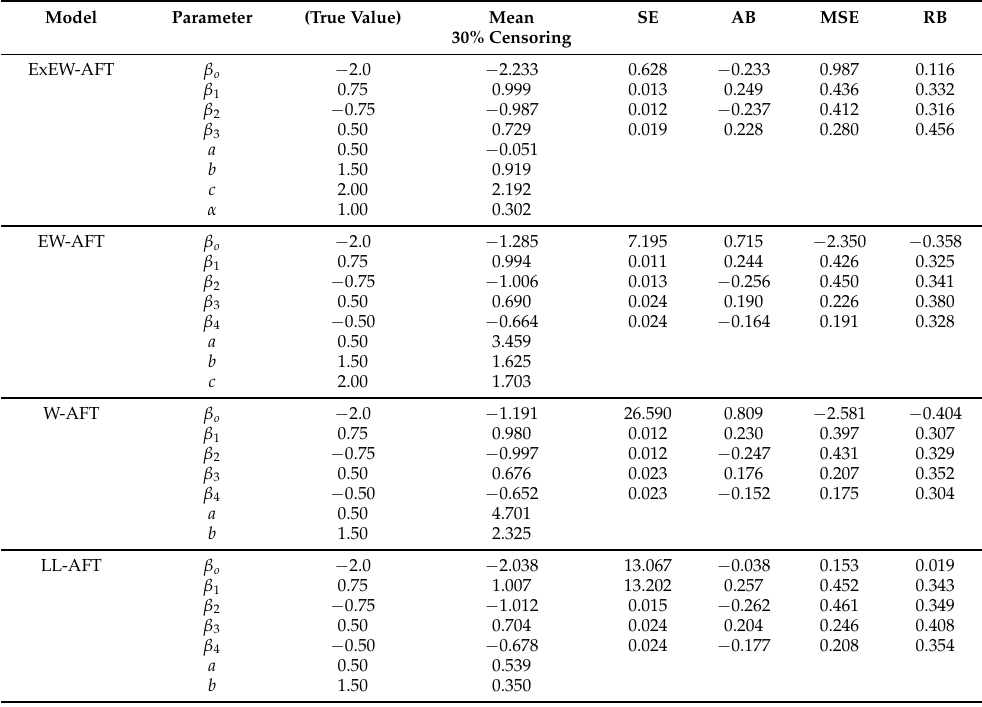
Table 12. Simulation study for scenario 3 ( n = 5000) with about 30% censored observations is used to compare model